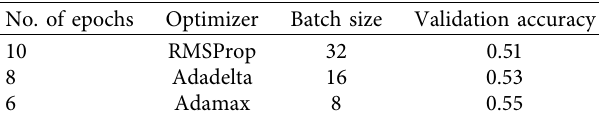
Figure 2: Model architecture of multimodal Table 1: Some of the best results obtained while training the model using the multimodal approach.